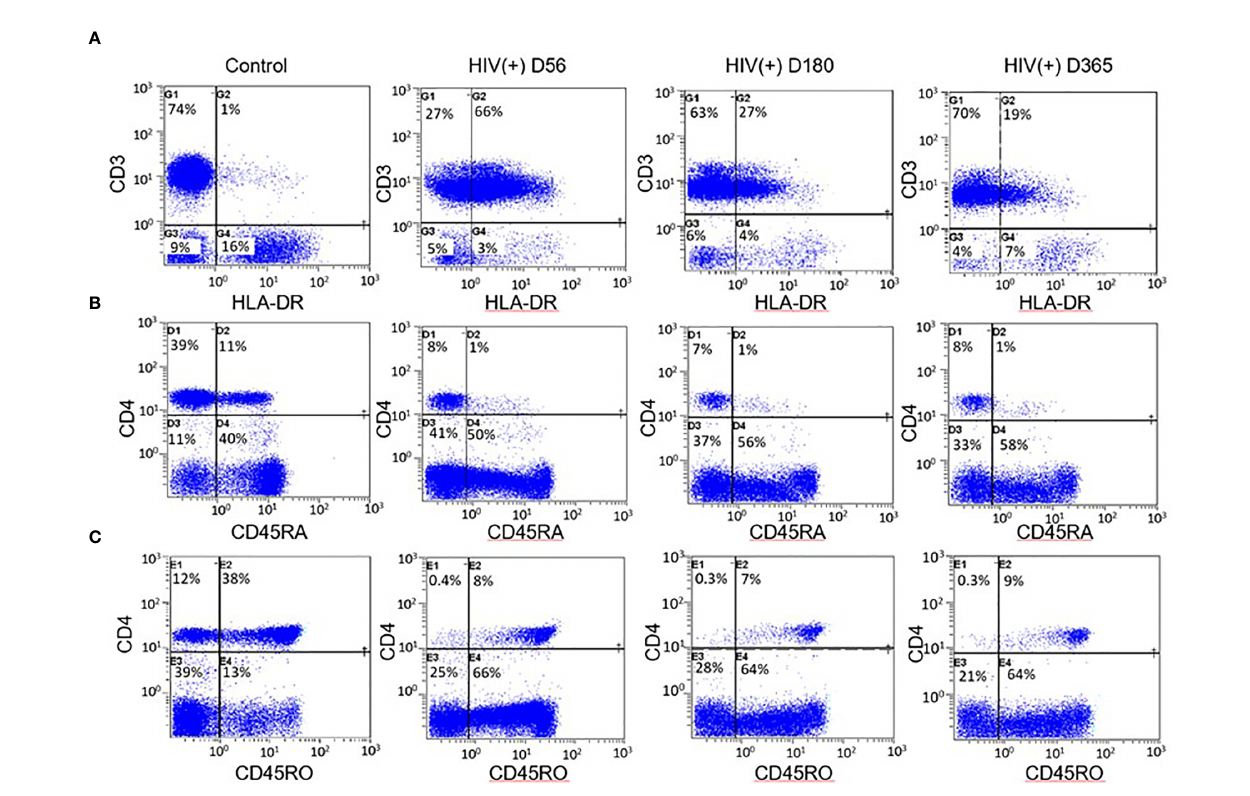
FIGURE 1 | Example fl ow cytometry comparison between HIV(+) AHCT recipient and control. (A) Percentage of CD3+ lymphocytes expressing the activation marker HLA-DR in healthy control and HIV(+) AHCT recipient on days 56, 180 and 365 post-transplant. (B) Percentage of CD4+ lymphocytes expressing the naïve cell marker CD45RA in healthy control and HIV(+) AHCT recipient on days 56, 180 and 365 post-transplant. (C) Percentage of CD4+ lymphocytes expressing the memory cell marker CD45RO in healthy control and HIV(+) AHCT recipient on days 56, 180 and 365